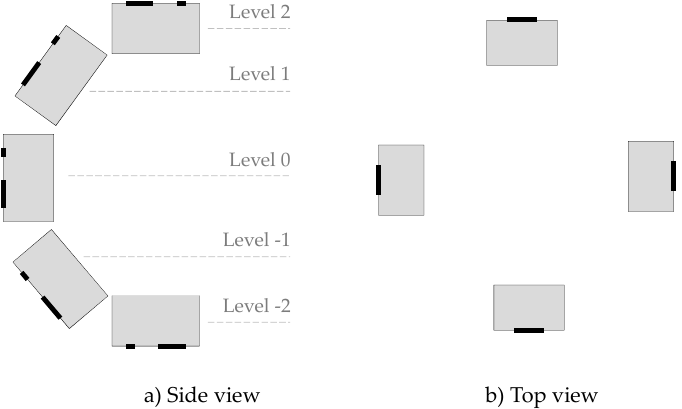
Figure 5. Side ( a ) and top ( b ) view for the measurements with a total sum of fourteen positions.